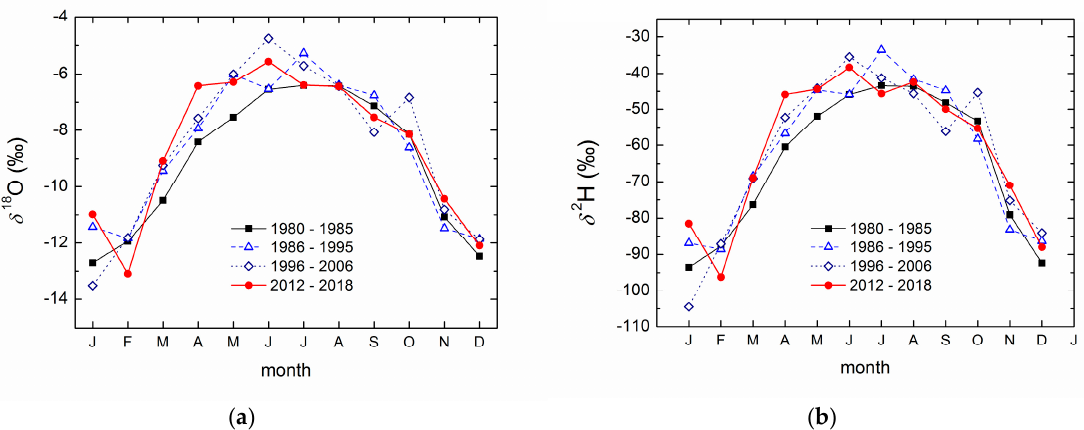
Figure 10. ( a ) Monthly mean values of δ 18 O in the four subperiods; ( b ) monthly mean values of δ 2 H in the four subperiods